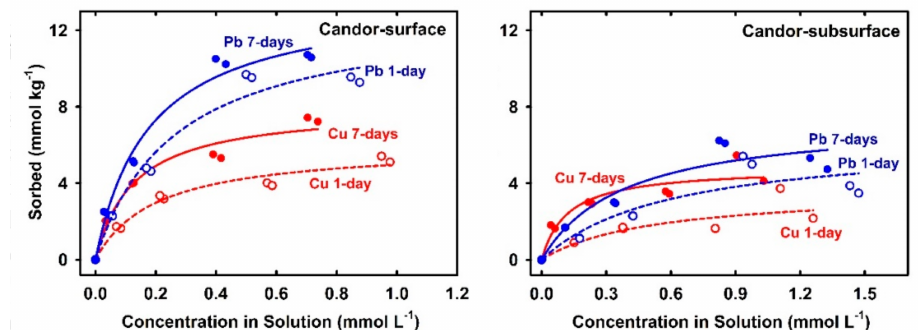
Figure 1. Sorption isotherms of Cu and Pb for acidic soils. The dashed and solid curves are Langmuir simulation for 1- and 7-days,